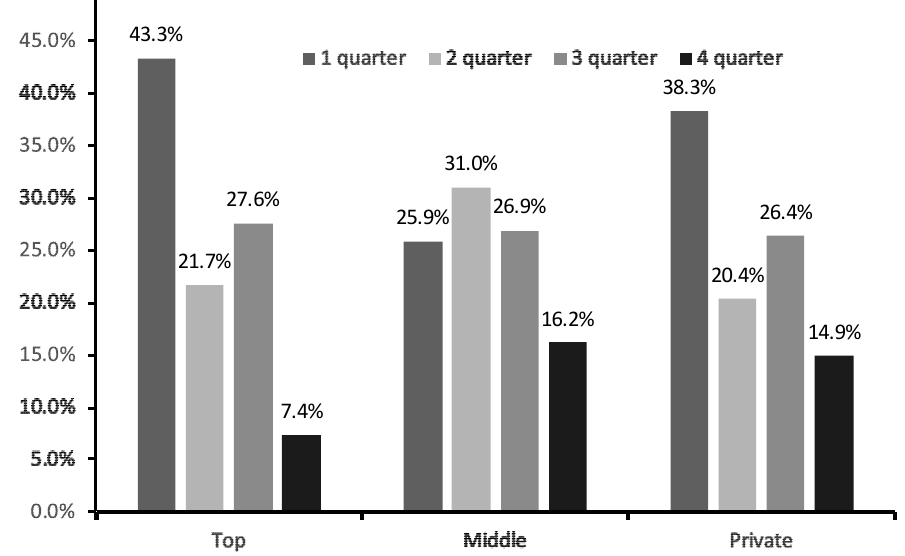
Relative age e ff ect (RAE) by performance group. Top = top-tier soccer academy; Figure 1. Relative age effect (RAE) by performance group. Top = top-tier soccer academy; Middle = Middle = middle-tier soccer academy; Private = academy of private middle-tier soccer academy; Private = academy of private school.